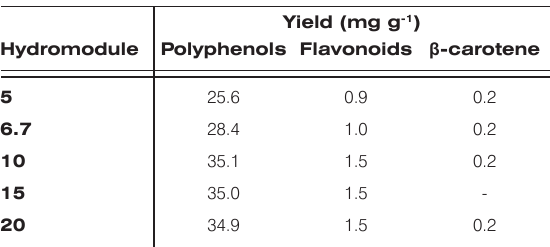
Table 1. Yield at different liquid/solid ratios (hydromodules). Yield (mg g -1 ) Hydromodule Polyphenols Flavonoids β